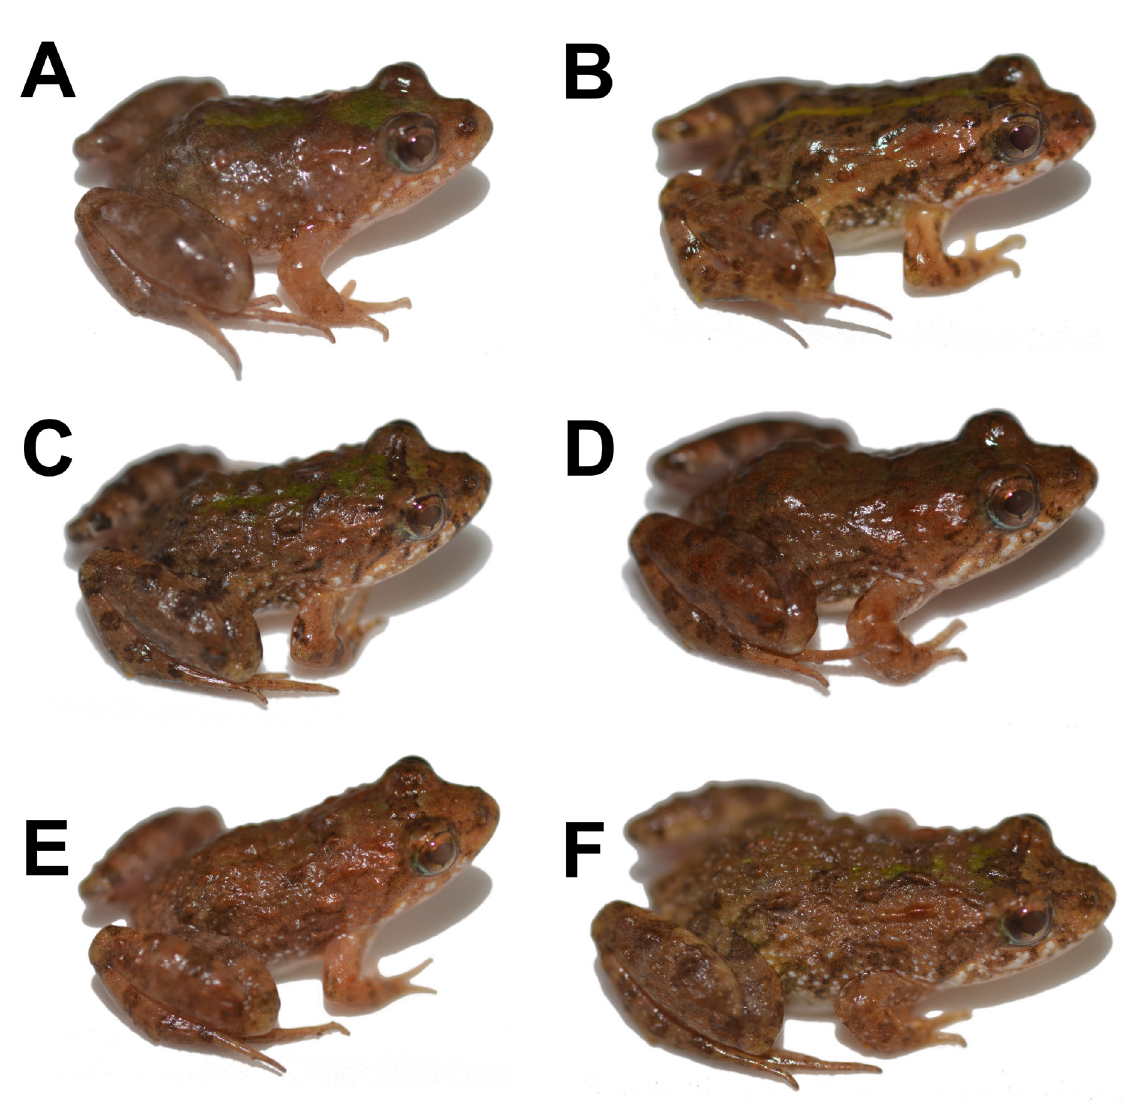
Fig. 3. Holotype and five paratypes of Pseudopaludicola matuta sp. nov. in life. A . Specimen ZUEC 24302 (holotype, adult ♂, call voucher; SVL = 13.0 mm). B . Specimen ZUEC 24304 (adult ♂, call and GenBank voucher; SVL = 13.3 mm). C . Specimen ZUEC 24303 (adult ♂, call and GenBank voucher; SVL = 12.8 mm). D . Specimen ZUEC 24305 (adult ♂ and call voucher; SVL = 13.4 mm). E . Specimen ZUEC 24308 (adult ♂, call and GenBank voucher; SVL = 13.5 mm). F . Specimen ZUEC 24307 (adult ♀ and GenBank voucher; SVL = 15.2